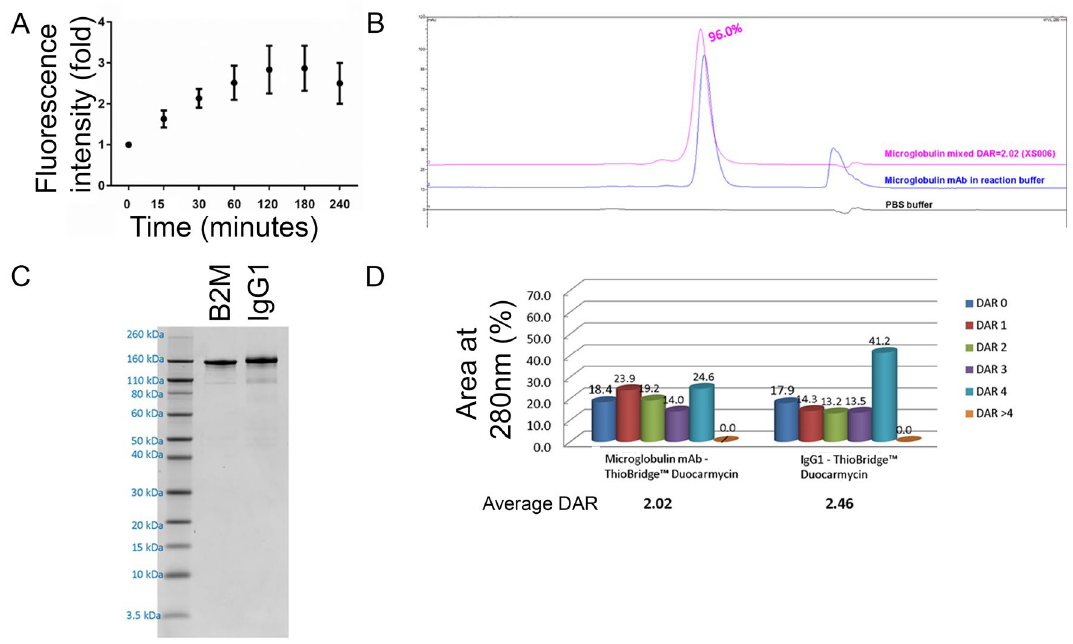
Figure 2. Characteristics of B2M-ADCs. ( A ) Internalization rate of the unconjugated B2M antibody in Control EJp16 cells as measured by CypHer5E fluorescence in a FACS analysis. Results show mean ± SD of three independent experiments. Results show mean ± SD of three independent experiments. ( B ) Size-Exclusion Chromatography characterization of the purity of the final ADC mix, compared to pure antibody and PBS. ( C ) SDS page comparing 1 µg of the unconjugated B2M antibody (UC) to an aliquot of the B2M ADC. ( D ) Quantitation of Drug-Antibody Ratios (DAR) of the B2M conjugated antibodies. Numbers indicate percentages of each DAR population in the mixture. Average DAR: